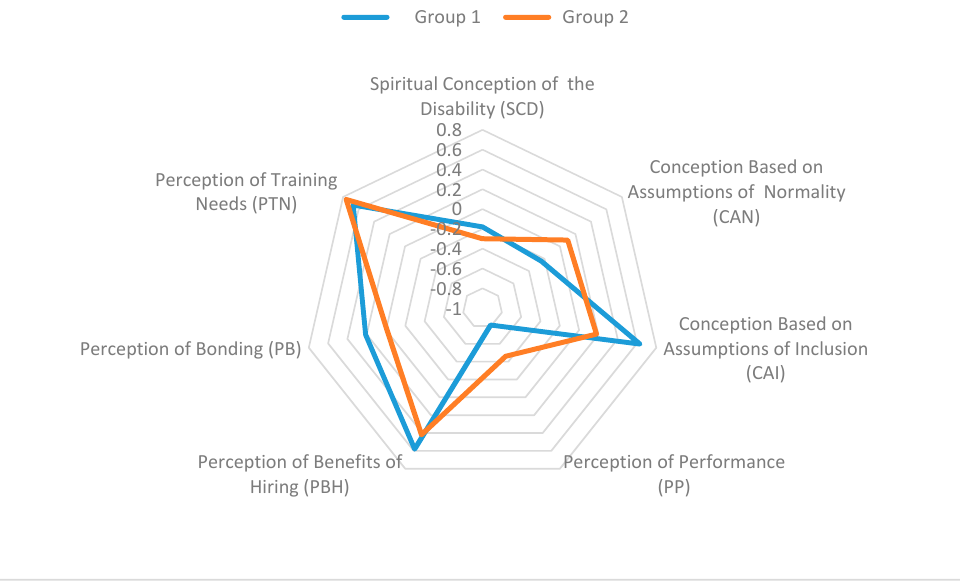
Figure 1. Star chart of profiles of managers.